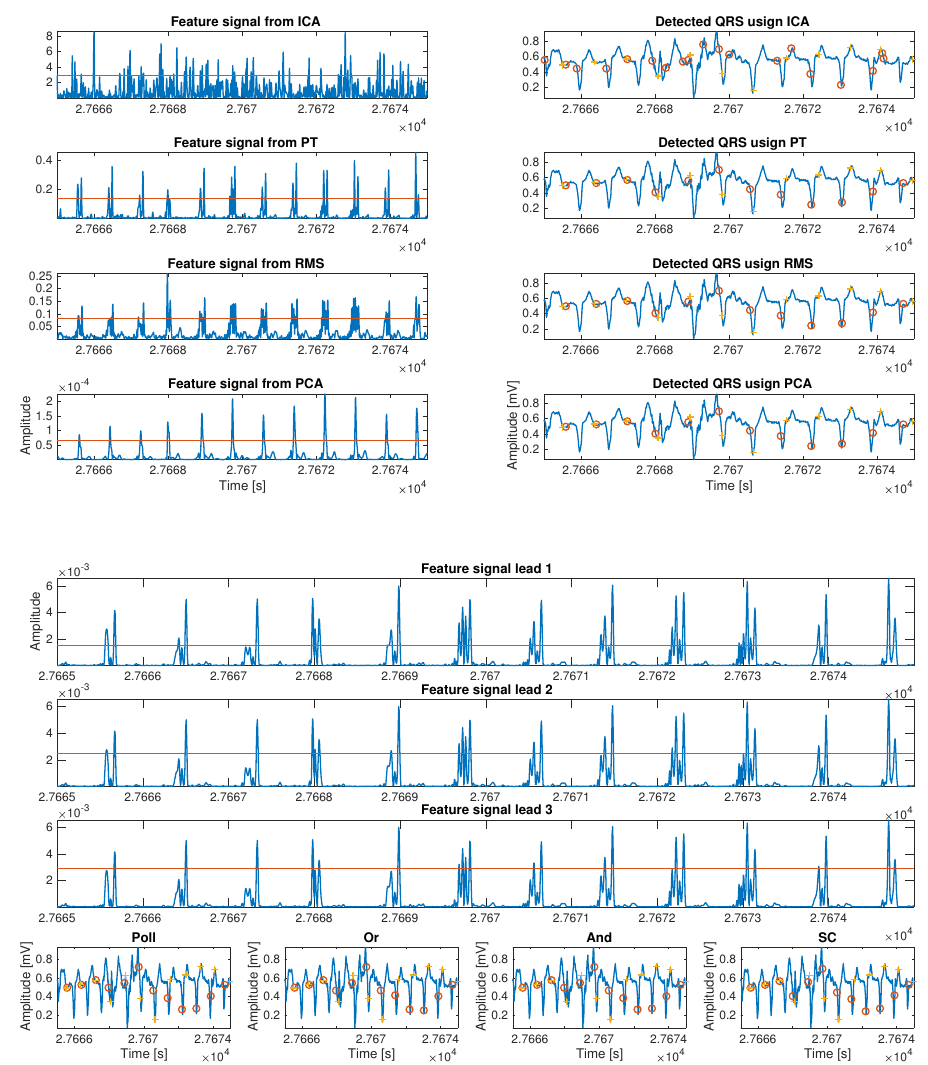
Figure 4. Thresholding process and peak detection for each proposed method. Panel one shows the feature signal, the threshold, and the peaks detected for the next methods, ICA, PCA, PT, and RMS. In panel two, the feature signal, the threshold, and the peaks detected for the combinational methods are presented. The yellow crosses shown the real peak presented in the signal, and the red circles shown the peak detected by each